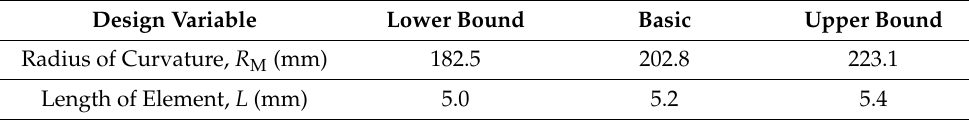
Table 1. Variation range of the design variables for the M-subarray